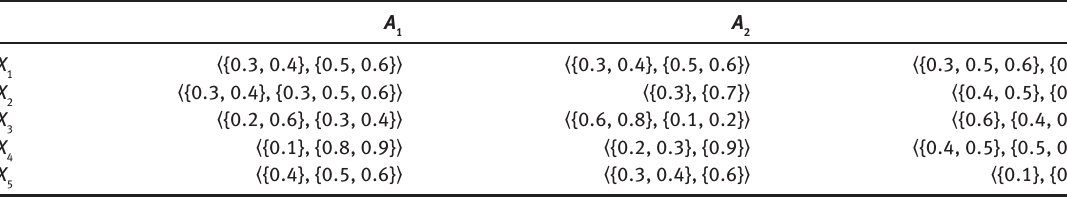
Table 7: Ordered Intuitionistic Hesitant Fuzzy Decision Matrix.